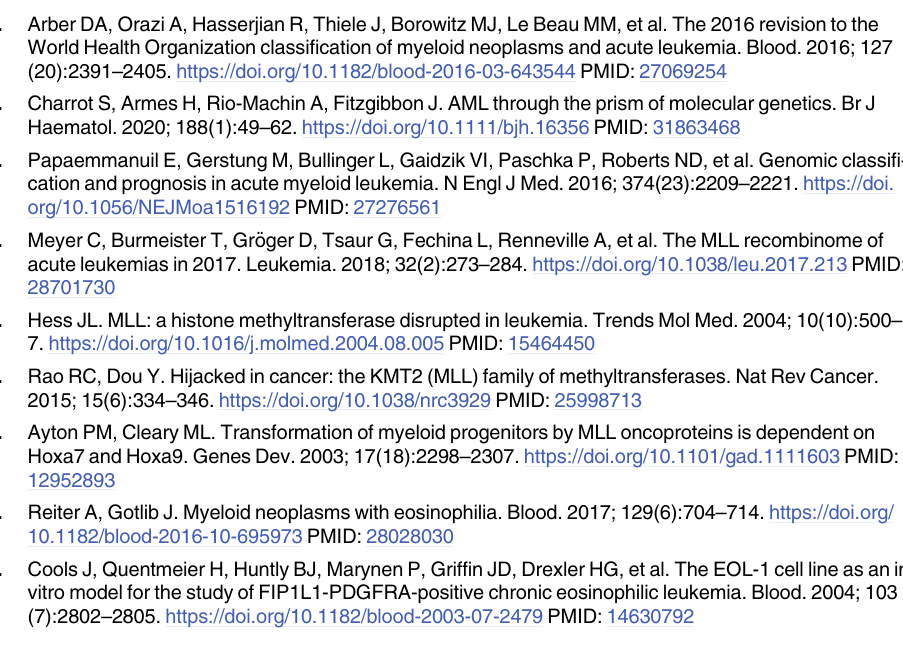
S9 Fig. ChIP-seq data for ELK1 in HELA-S3 (ENCODE). The peaks at the transcriptional start site and in the upstream region (red arrow, corresponding to the mutated site in EOL-1) indicate ELK1 interaction at the HMX-locus.